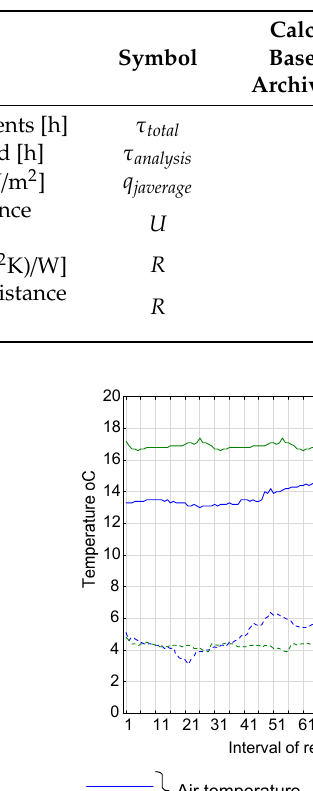
Table 4. Calculated and measured thermal transmittance.